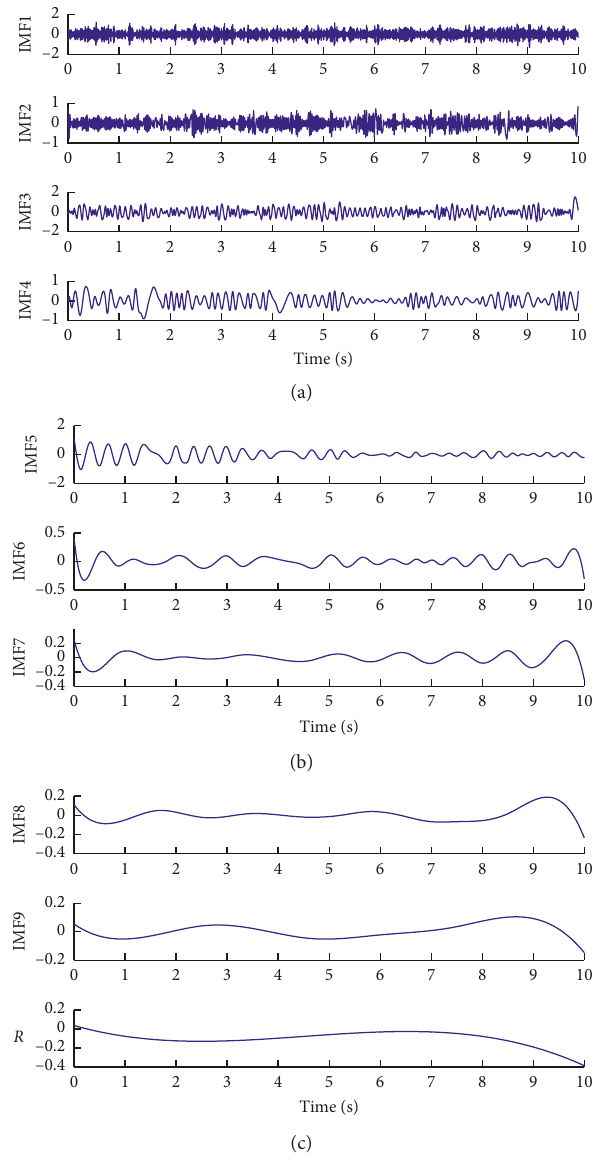
Figure 3: EEMD results of noise signal. (a) IMF1 ∼ IMF4. (b) IMF5 ∼ IMF7. (c) IMF8, IMF9, and residual